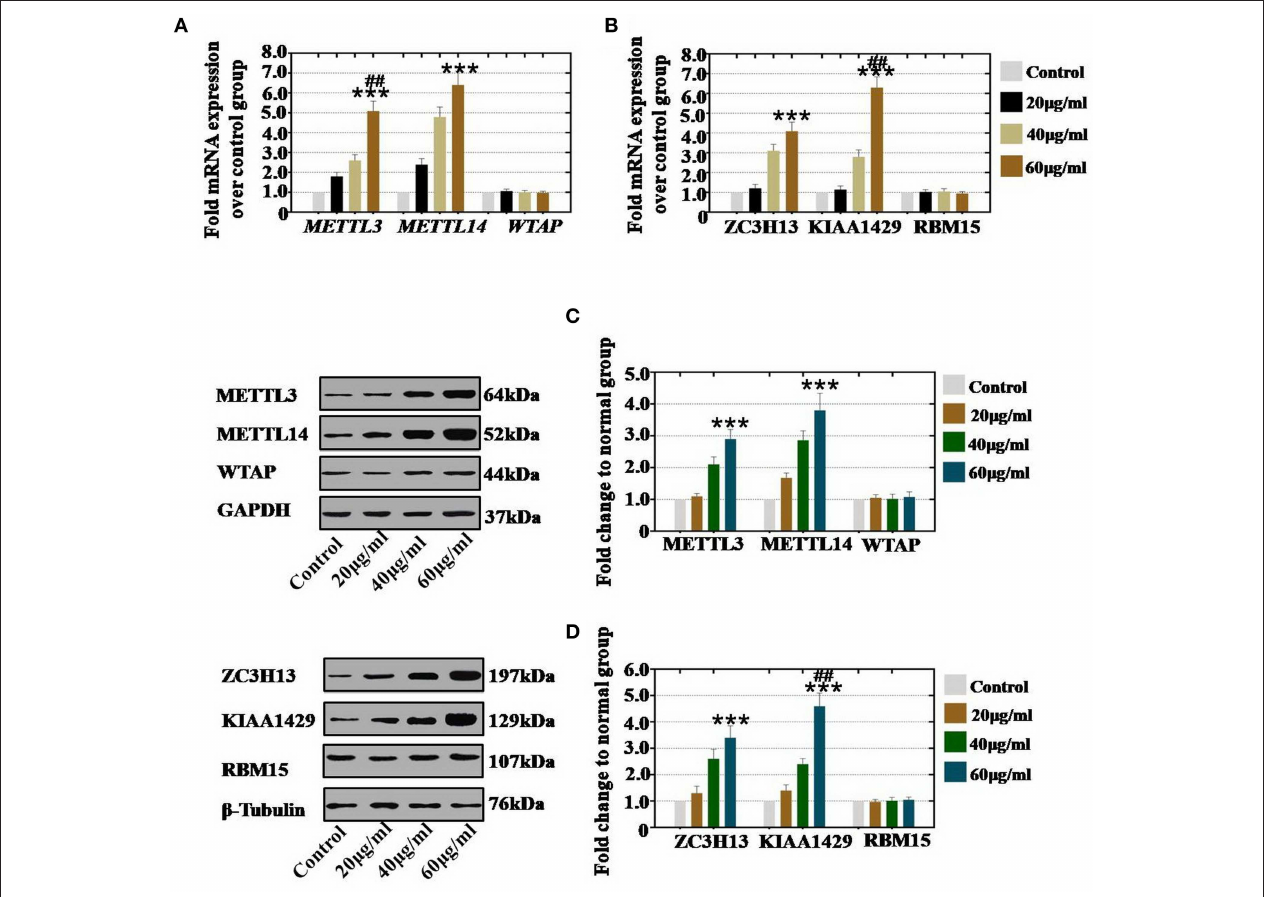
FIGURE 2 | Quantification and concentration-dependence analysis of the RNA methyltransferases expression levels after CTX treatment in vivo . (A) The mRNA expression levels of METTL3, METTL14 and WTAP in hGCs were measured after treatment with CTX (20, 40, and 60 µ g/ml). (B) The mRNA expression levels of ZC3H13, KIAA1429, and RBM15 in hGCs were measured after treatment with CTX (20, 40, and 60 µ g/ml). (C) The protein expression levels of METTL3, METTL14 and WTAP in hGCs were measured after treatment with CTX (20, 40, and 60 µ g/ml). (D) The protein expression levels of ZC3H13, KIAA1429, and RBM15 in hGCs were measured after treatment with CTX (20, 40, and 60 µ g/ml). All experiments were performed three times. The error bars indicate SD; *** p < 0.001 (compared with control group); ## p < 0.01 (compared with the 40 µ g/ml CTX concentration group).